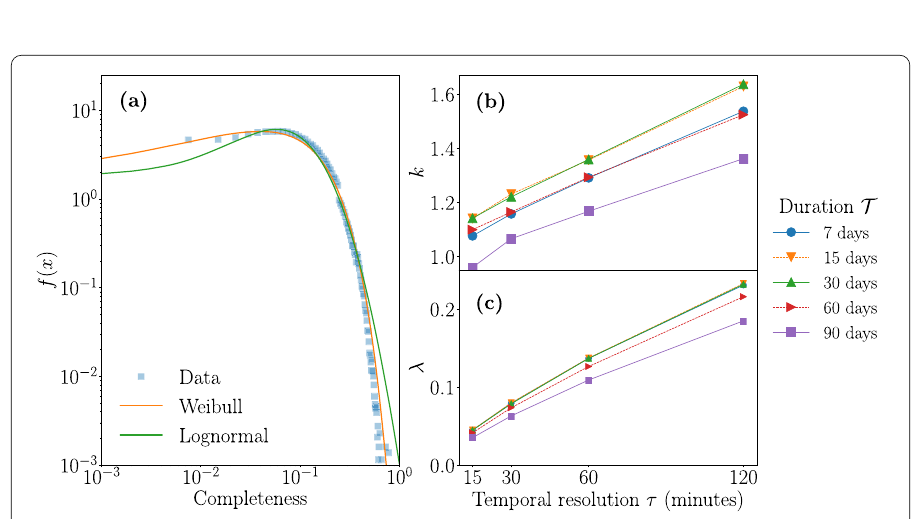
Figure 3 Fitting completeness into long-tailed distributions. ( a ) Empirical PDF of the completeness of 1.8 million user trajectories, with Weibull and lognormal theoretical fittings, for T = 60 days and τ = 60 minutes. ( b )( c ) Weibull variables k and λ versus the temporal resolution τ and observation period